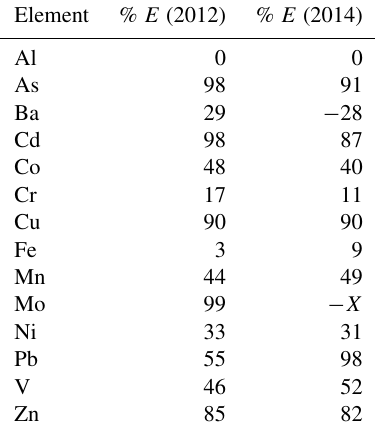
Table 6. Percent of total concentration that is represented by E (the difference between total minus dust contribution). The larger the contribution from dust, the lower the